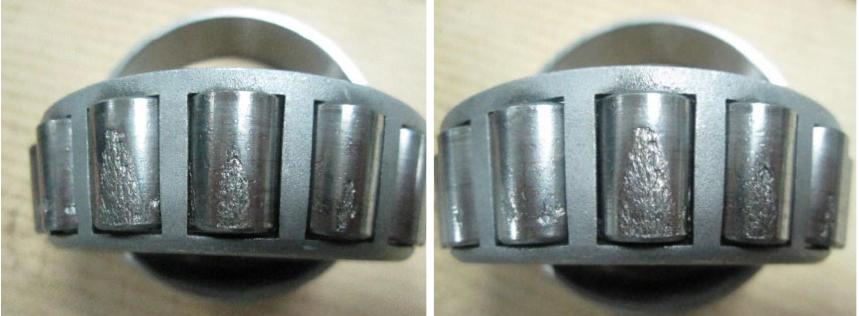
Figure 4. Defects of the failure bearings. After the system failure, the vibration data were processed by Dual-BP and MCA, respectively. As with the previous case, three representative moments were analyzed: 25 h (300th group, normal stage), 60 h (533th group, incipient fault) and 95 h (1140th group, fault stage). The raw vibration signals and the reconstructed signals via Dual-BP and MCA are shown in Figures 5–7, respectively. The short-time Fourier transform (STFT) of harmonic component and impulse component are shown in Figures 8–10,